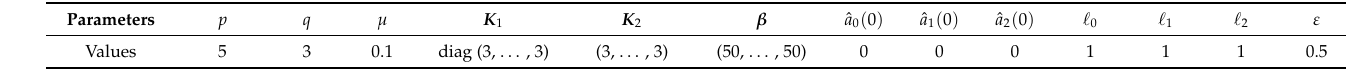
Table 3. Controller